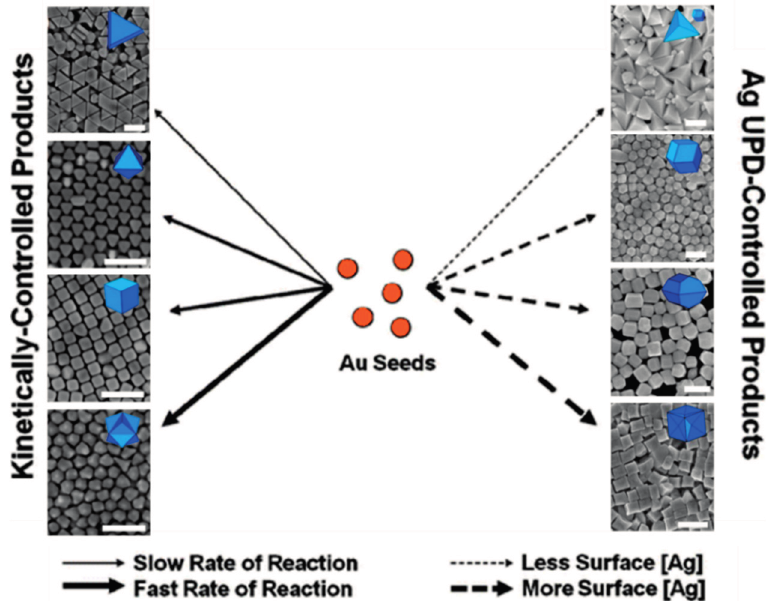
Figure 1. General rules of shape-control in silver-assisted, seed-mediated gold nanoparticles synthesis, where the shape of nanoparticles can be controlled simply by altering the reaction rate or altering the silver concentration. Scale bars are 200 nm. Adapted with permission from reference [12]. Copyright 2012 American Chemical